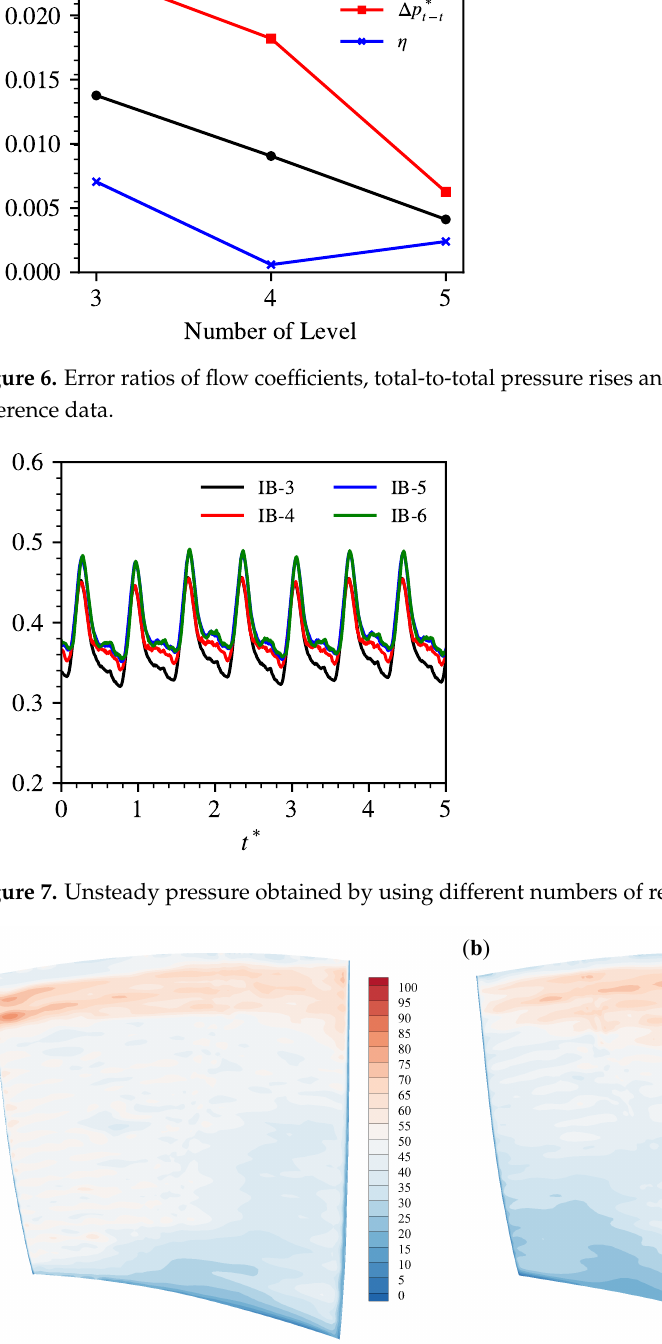
Figure 8. Distributions of y + on the rotor blade. ( a ) Pressure surface and ( b ) suction